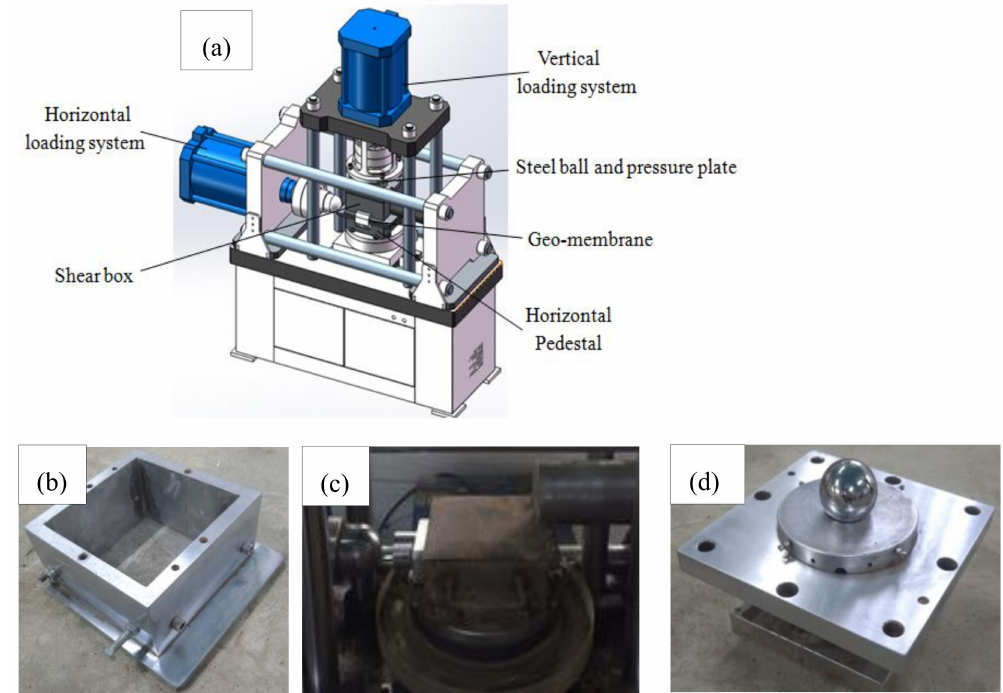
Figure 1. Test equipment: ( a ) schematic view of fracture shear-seepage coupling test system; ( b ) shear box; ( c ) horizontal pedestal; ( d ) steel ball and pressure plate.